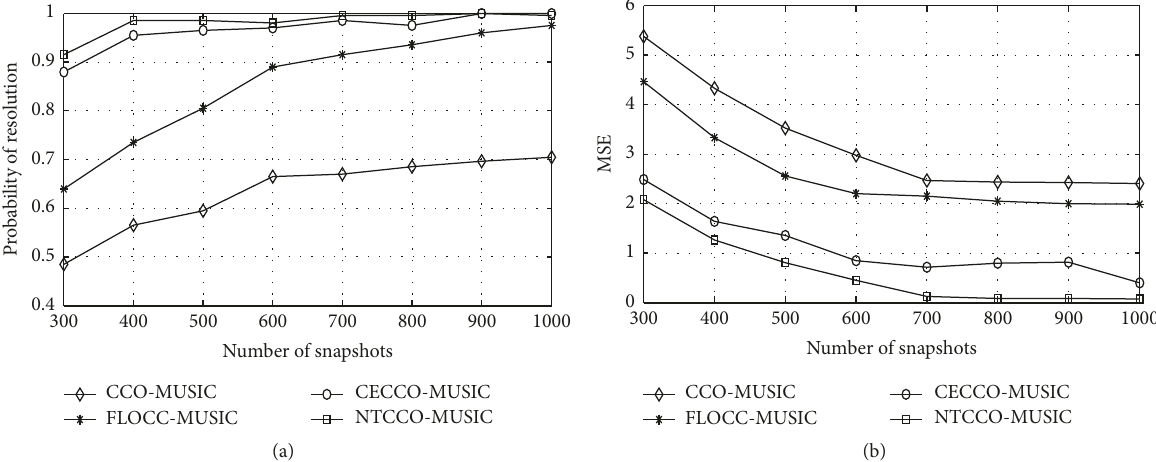
Figure 5: Probability of resolution (a) and MSE (b) versus number of